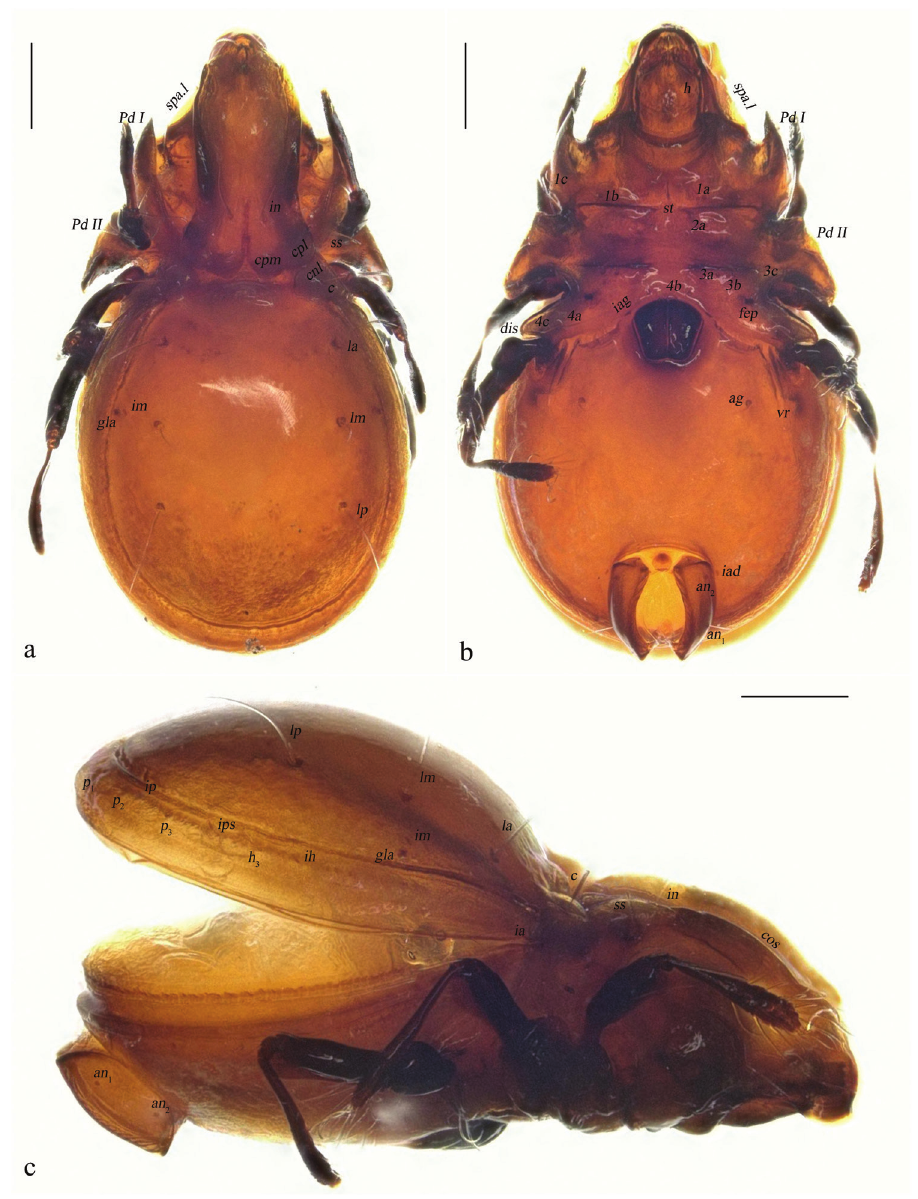
Figure 7. Eurostocepheus (Eurostocepheus) sinutus sp. nov., adult, microscope images: a dorsal view b ven- tral view c lateral view. Abbreviations and notations explained in text. Scale bars: 200μm.